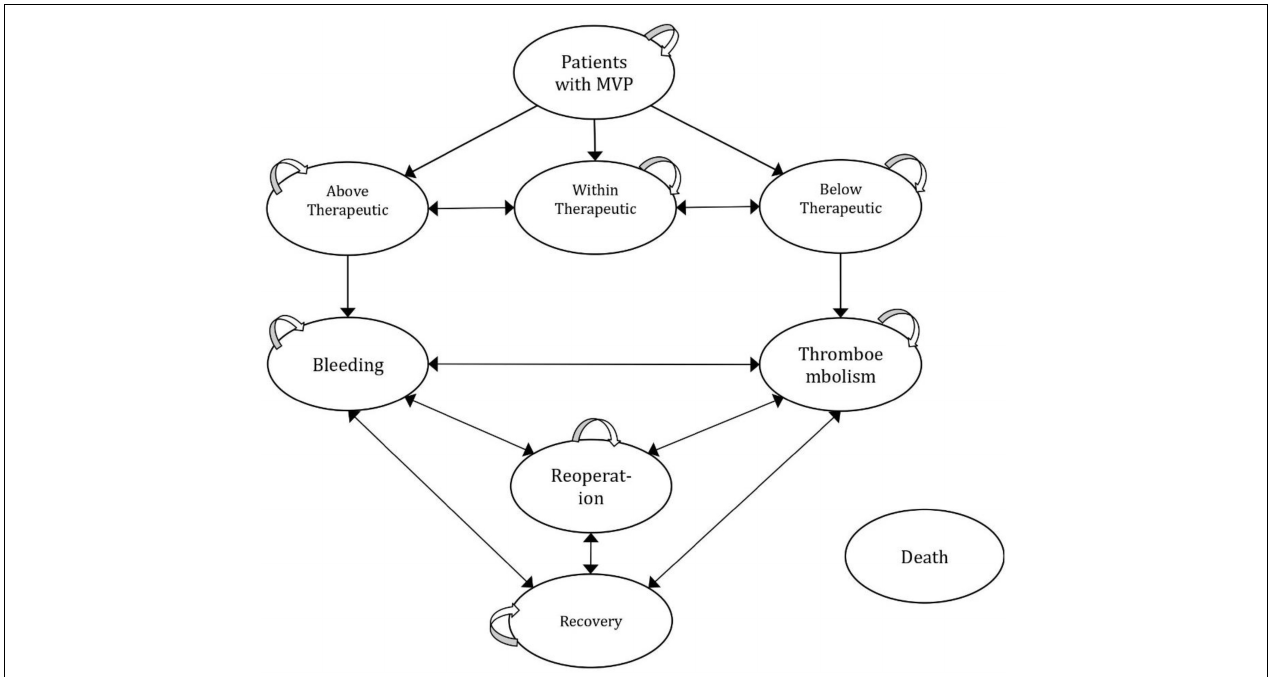
FIGURE 1 | Schematic diagram for the Markov state